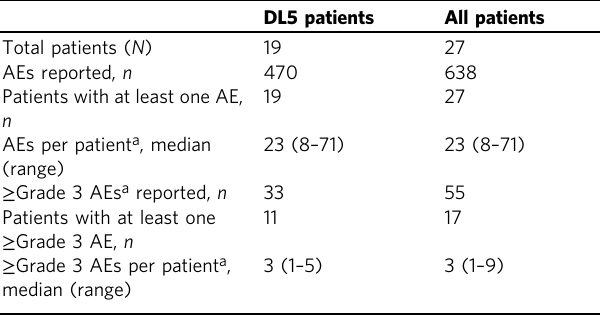
Table 1 Adverse events for STARPAC clinical